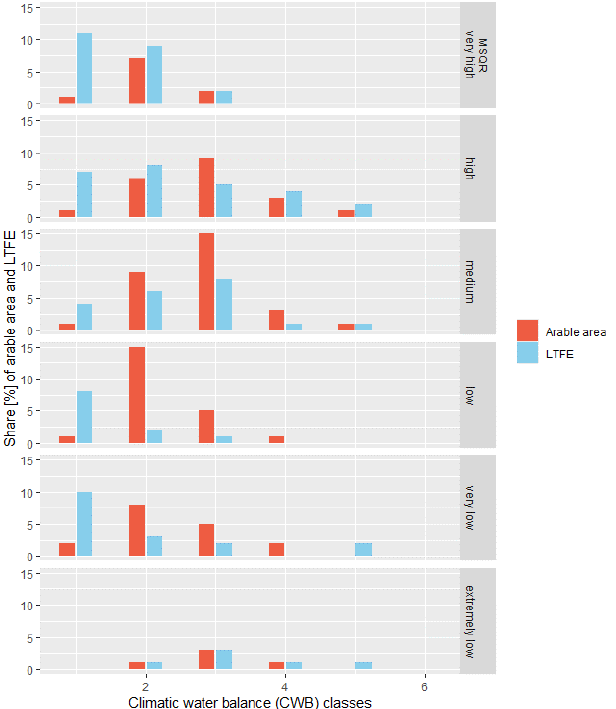
Figure 6. Share of arable area and LTFEs in every climatic water balance and Müncheberg Soil Quality Rating